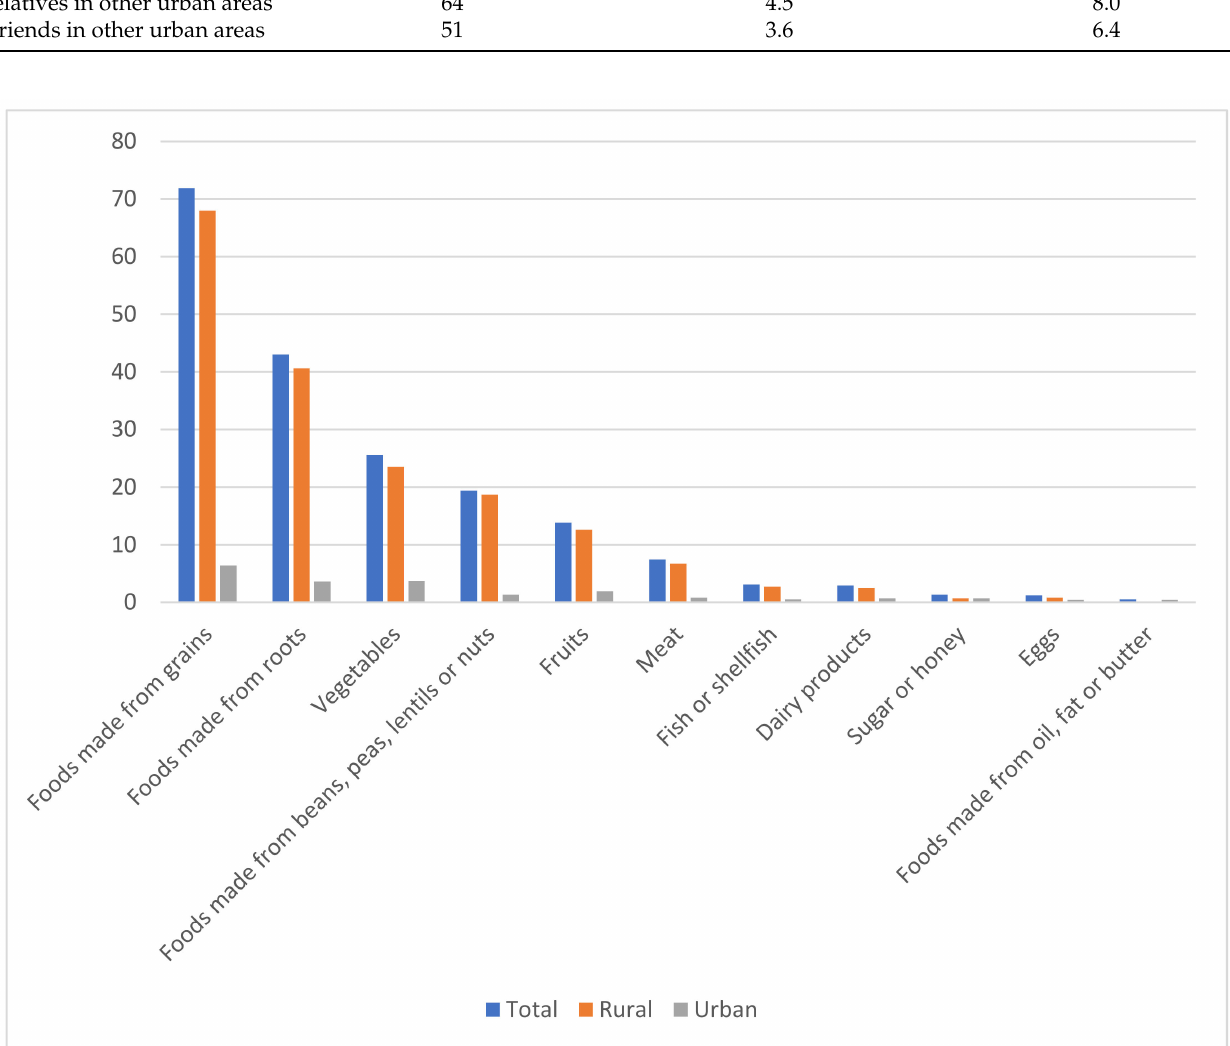
Figure 1. Food Remittances by Type and Geographical